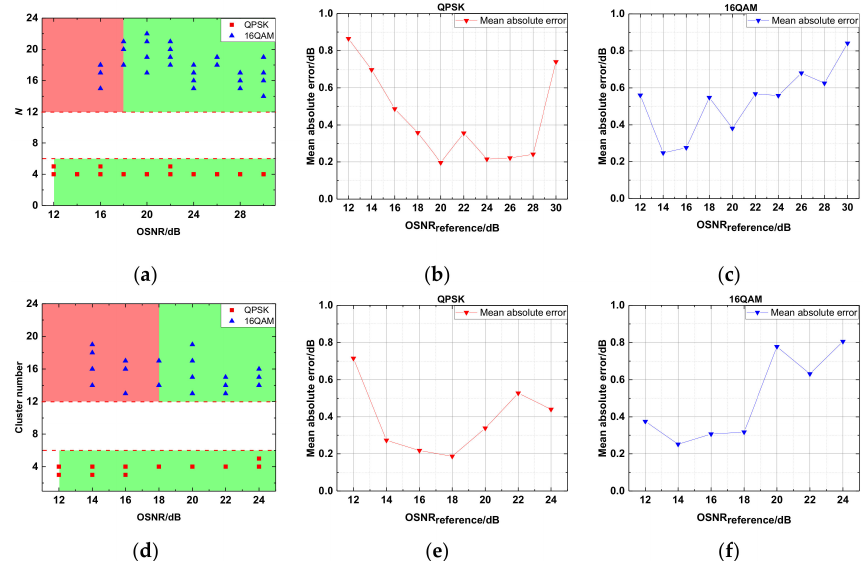
Figure 9. Experimental results of MFI and OSNR estimation for 20 GBaud QPSK and 16QAM